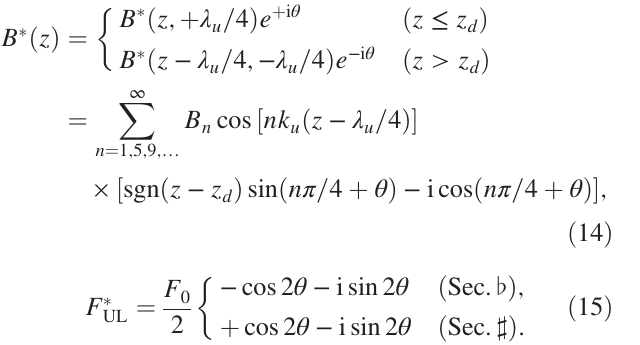
by the additional phase shift. u